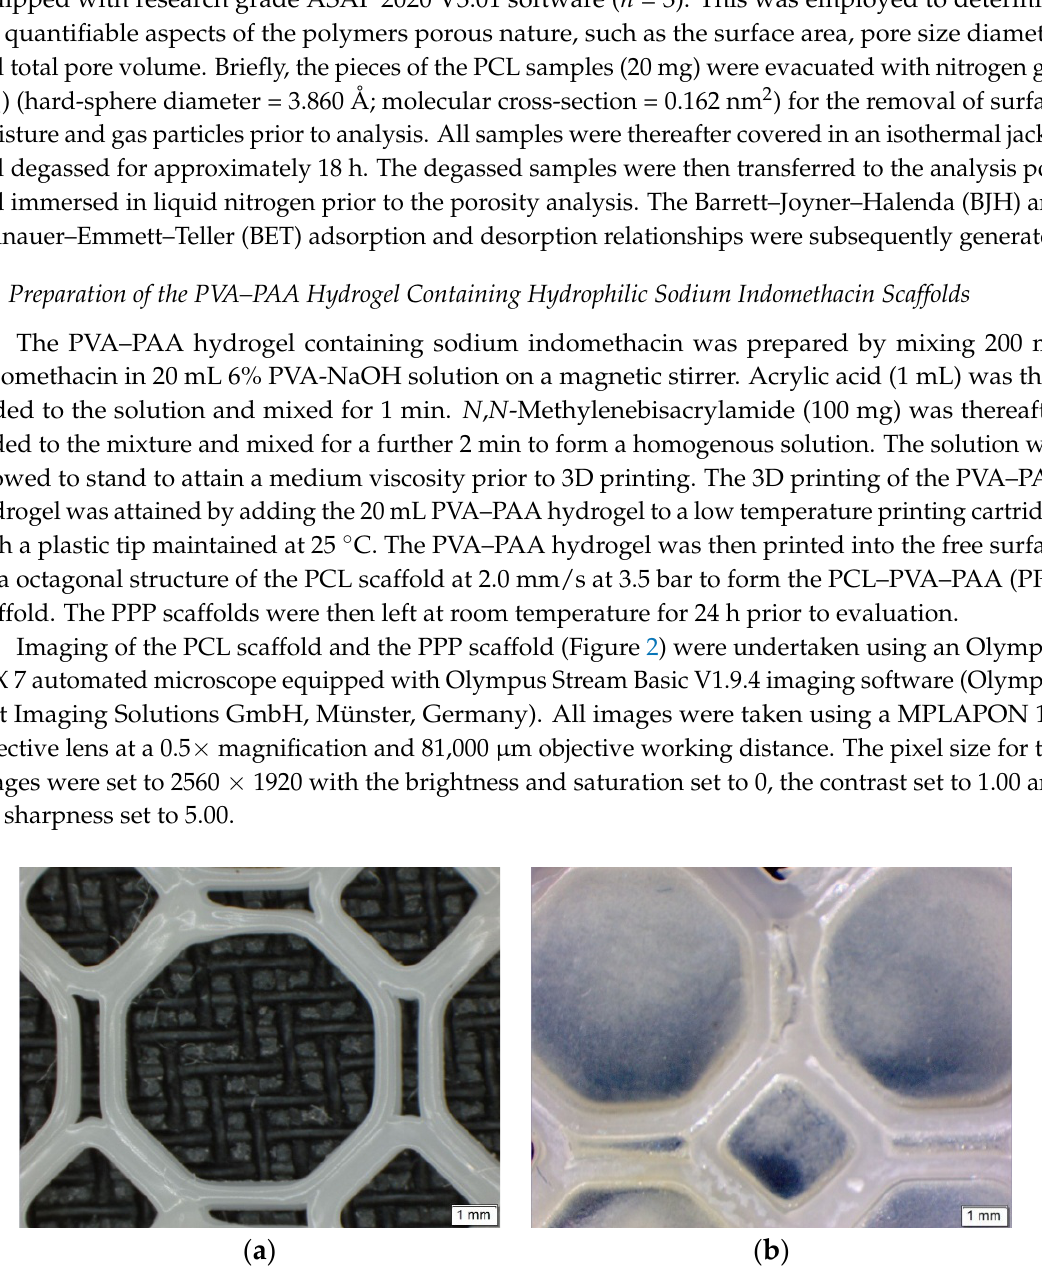
Figure 2. Microscopic images of ( a ) the 3D printed PCL scaffold and ( b ) the PPP scaffold highlighting uniform adhesion of the PVA–PAA hydrogel within the octagonal structure.